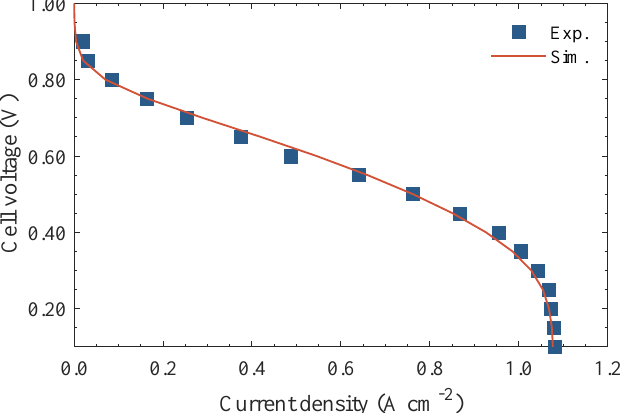
Figure 4. Comparison with steady-state measured data of the PEMFC [34].